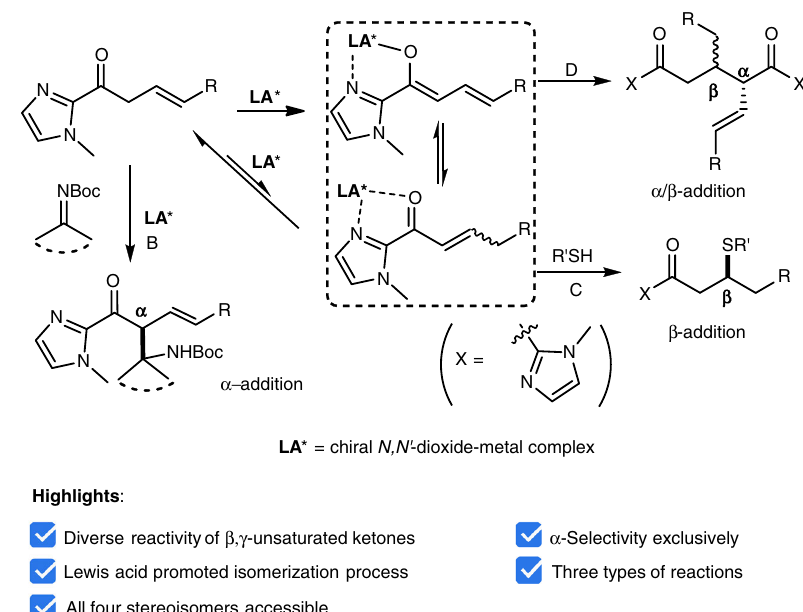
Fig. 1 Strategies for γ - and α -addition of β , γ -unsaturated carbonyl compounds. a Regioselectivity of decojugated carbonyl compounds. b Our strategies for diverse reactivity of β , γ -unsaturated 2-acyl